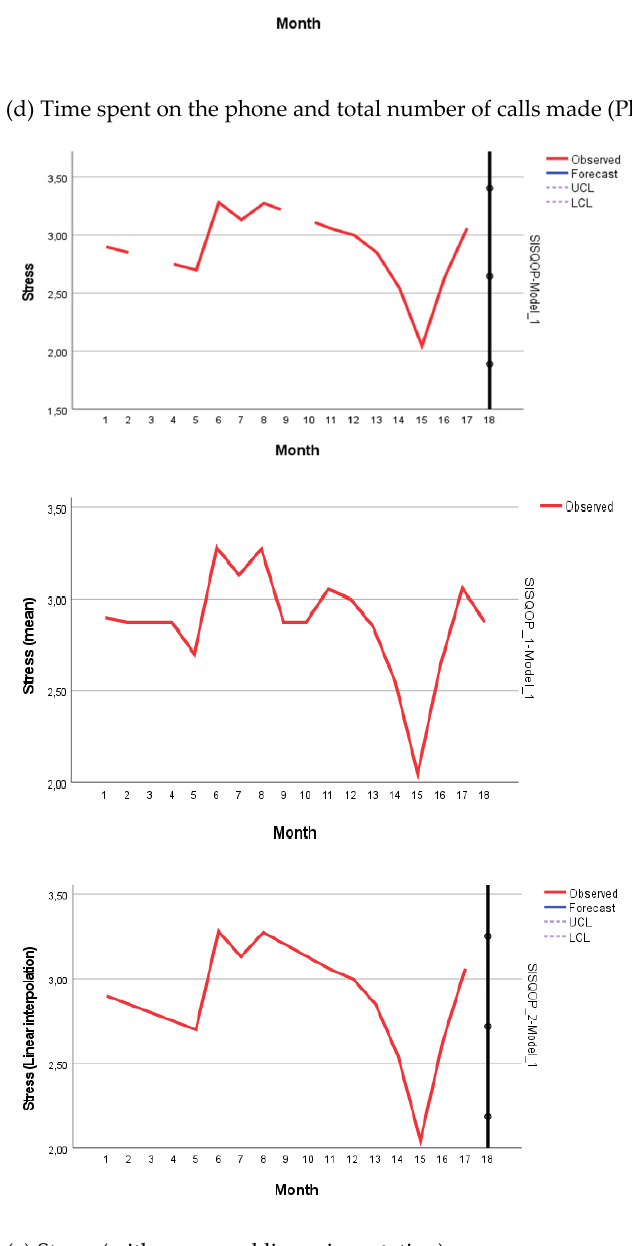
Figure A1. Monthly ratios of objective work performance: ( a ) total number of tasks (Tasks) to total number of hours performed; ( b ) Time and total number of visits; ( c ) Time spent on administrative tasks (Admin) to total number of administrative tasks; ( d ) Time spent on the phone and total number of calls made (Phone); and ( e ) Stress (with mean and linear